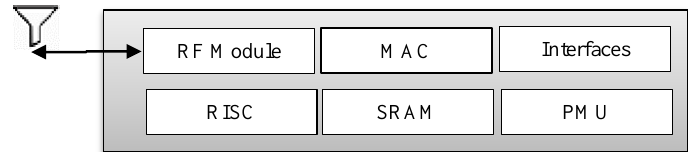
Figure 7. Node MCU functional diagram